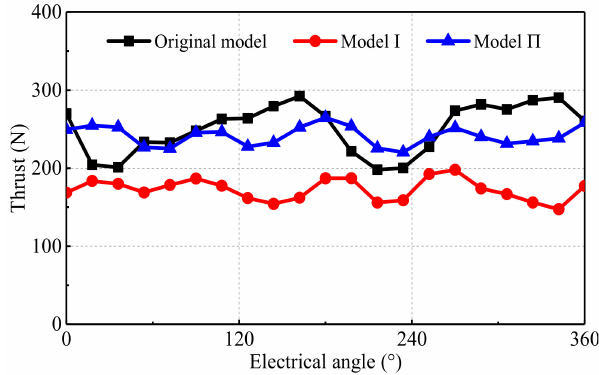
Figure 18. Thrust waveforms.